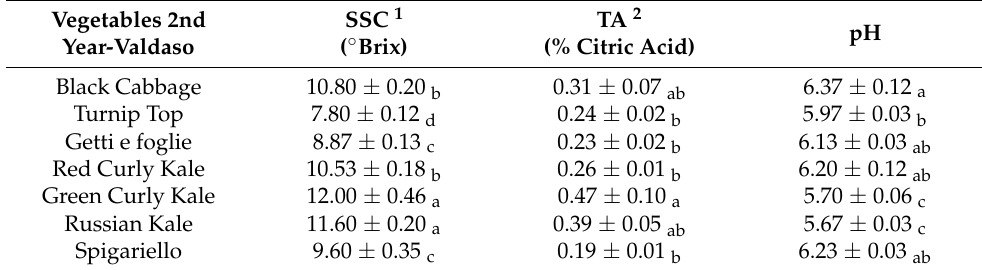
Table 3. Sensorial quality parameters of vegetables cultivated during 2nd year (2017) of trial in Valdaso area.